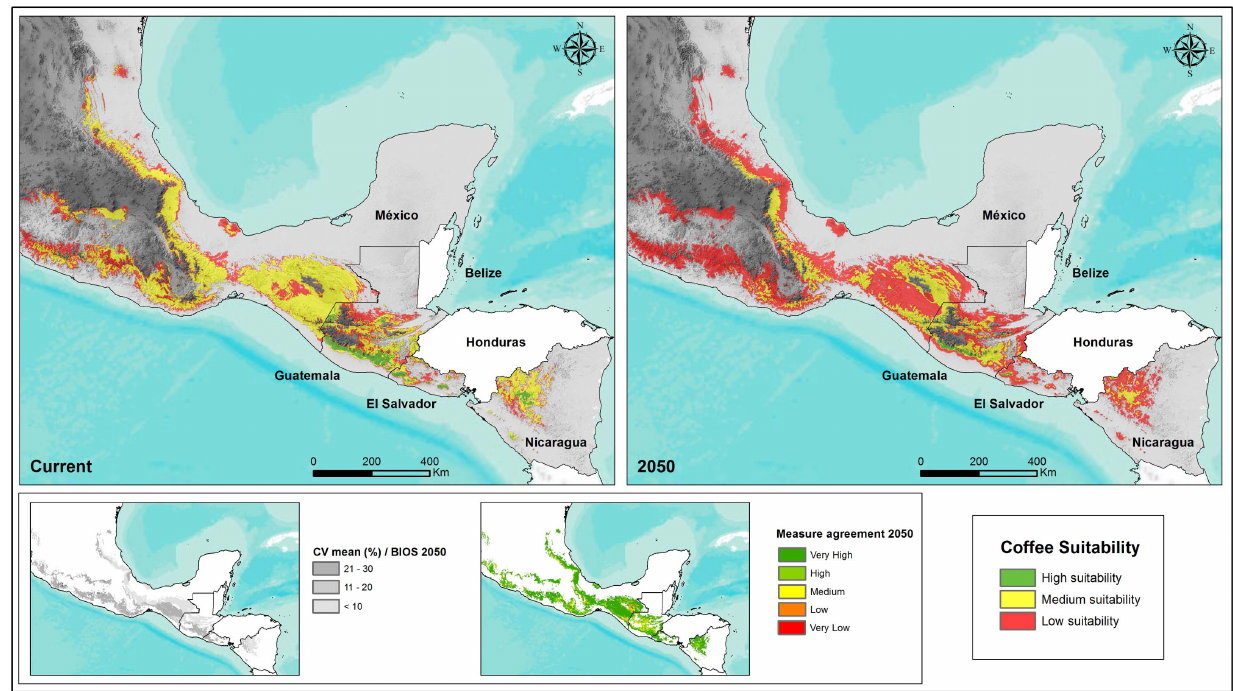
Figure 2. Prediction of the relative climatic suitability for Arabica coffee production in Mexico, Guatemala, El Salvador and Nicaragua in 2010 and 2050 (large maps), coefficient of variation (CV; small map to the left), and consistency between models (small map to the mid-right). doi:10.1371/journal.pone.0088463.g002 PLOS ONE |